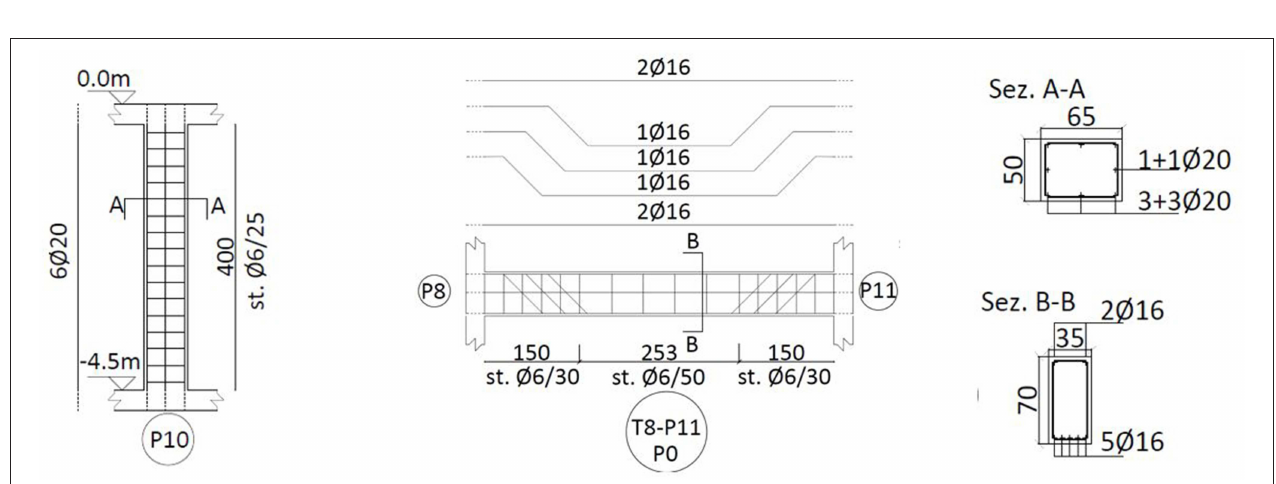
FIGURE 2 | Investigation campaign: (A) Material properties derived from extracted samples. N, number of samples; CV, coefficient of variation; f cm , average compressive strength; f ym , average tensile strength; (B) steel reinforcements disposition obtained through pacometric investigations and sampling of concrete specimen, (C) steel samples collected.